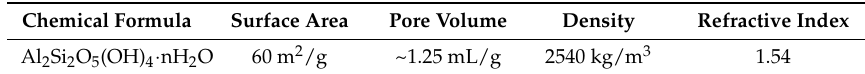
Table 3. Physical properties of HNTs.